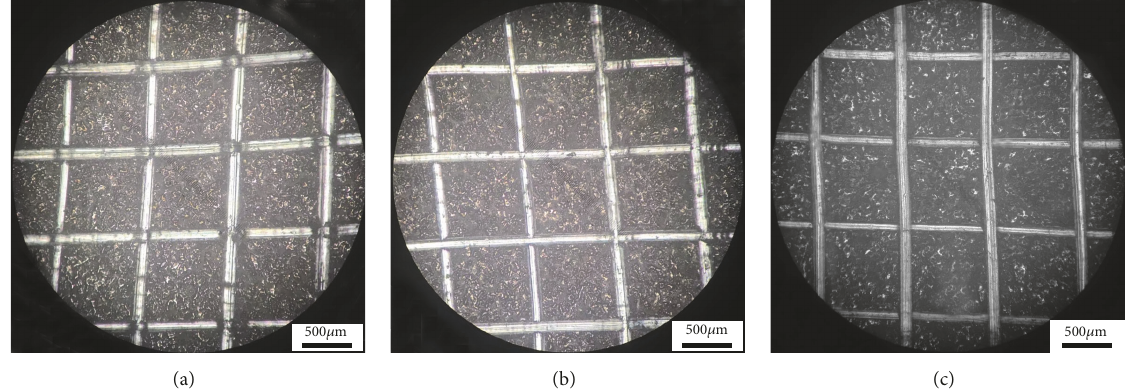
Figure 3: Adhesion test of conversion coatings with various process on AZ91D alloys: (a) CO 2 24h, (b) CO 2 2h/pH11.5 2h, and (c) CO 2 3MPa 0.5h.